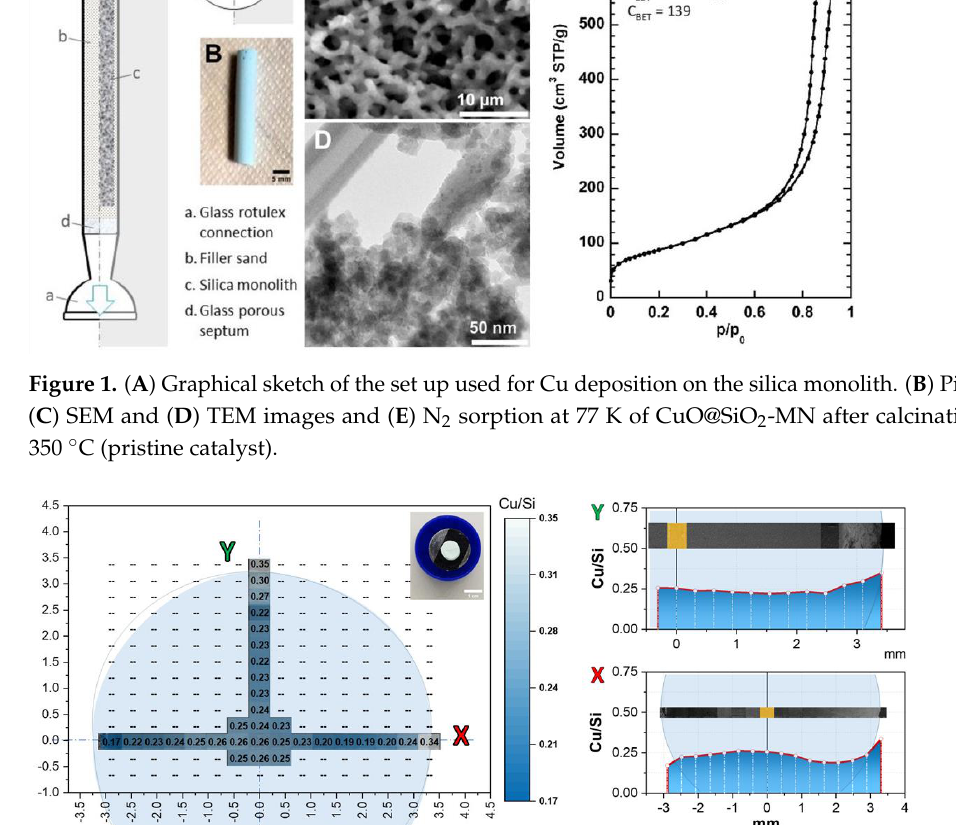
Figure 3. Representative HAADF-STEM micrograph of the fresh CuO@SiO 2 -MN and related histo- gram of particle size distribution.